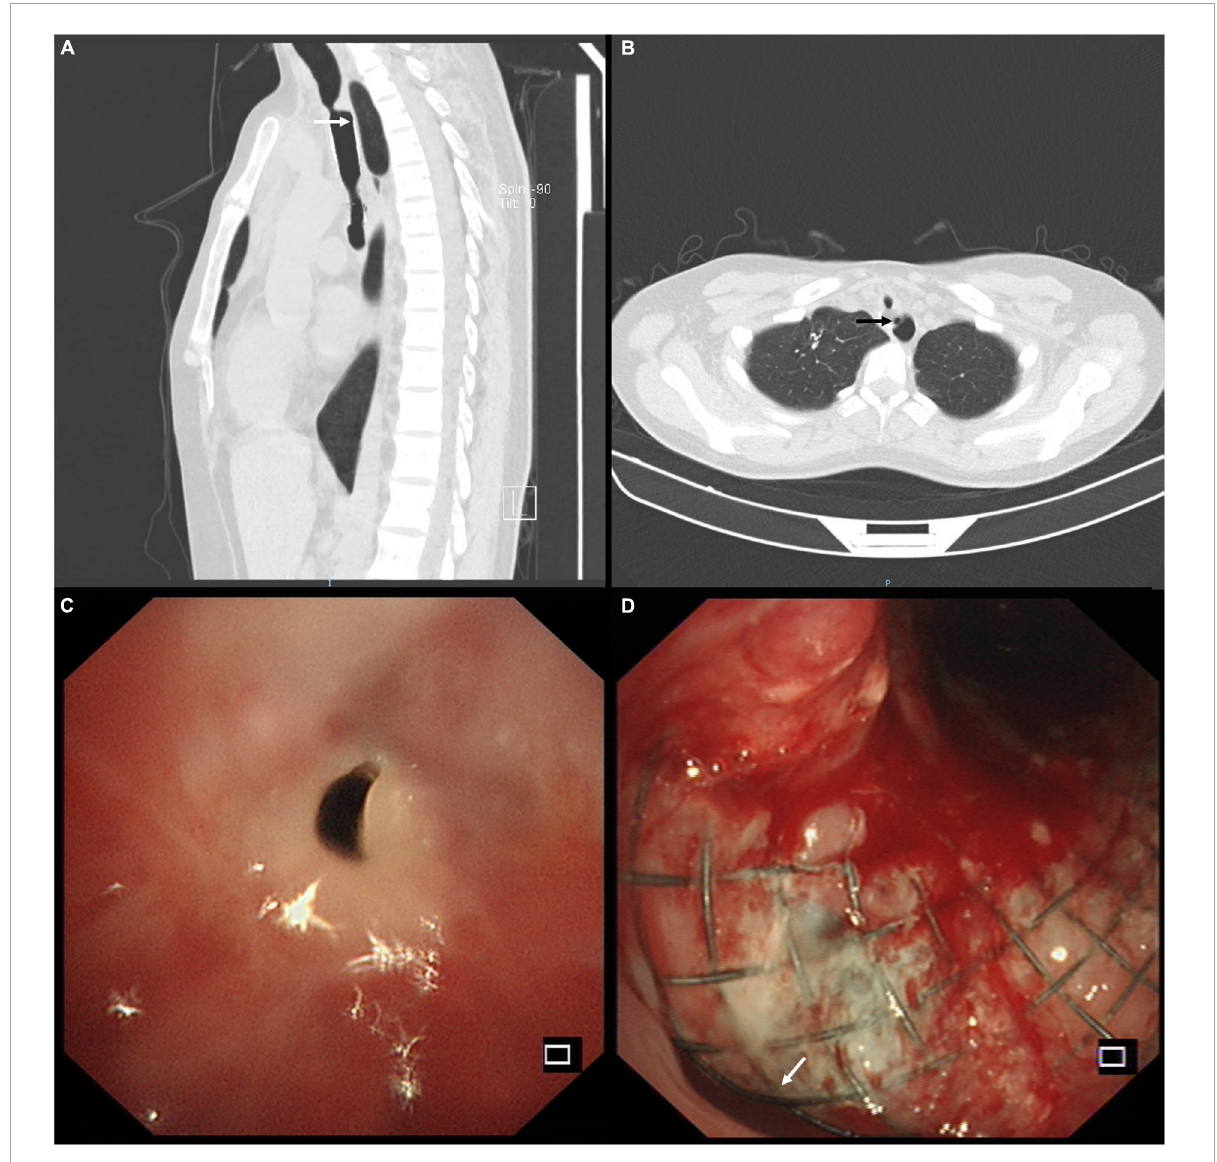
FIGURE1 (A) Sagittal chest computed tomography (CT) view showed the severe granulation tissue hyperplasia on the upper edge of the covered self-expandable metallic stent (SEMS) and the shearing force against the anterior esophageal wall (white arrow). (B) Axial chest CT view showed severe granulation tissue hyperplasia and tracheoesophageal fistula (TEF) (black arrow) on the upper edge of the SEMS. (C) The bronchoscopy confirmed severe granulation tissue hyperplasia on the upper edge of the covered SEMS, causing 90% airway obstruction. (D) The bronchoscopy identified the TEF (white arrow) located in the 7 o’clock position after eradicating the severe granulation tissue